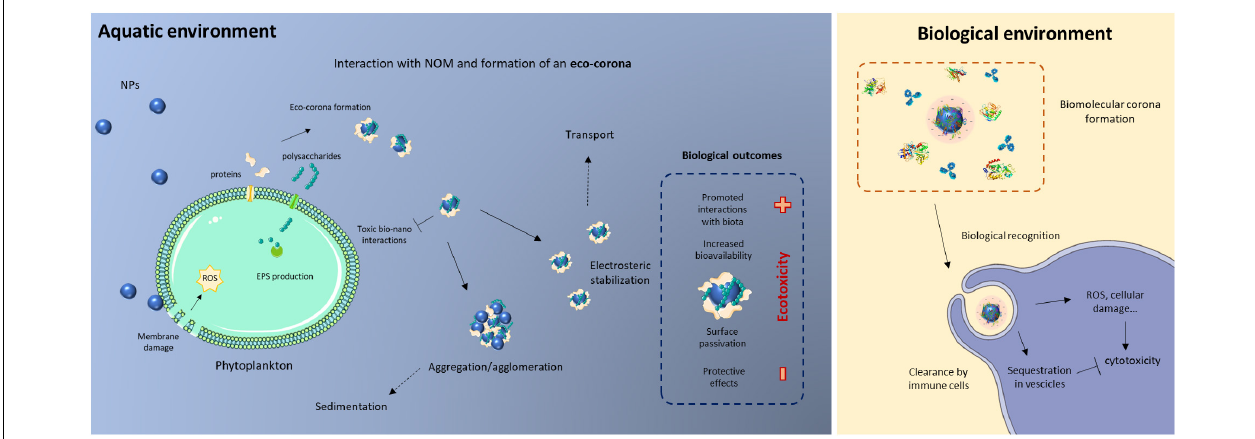
FIGURE 1 | Schematic illustration of the bio–nano interactions taking place in the marine environment. Left: possible interactions between nanoscale particles (NPs) dispersed in seawater and biomolecules making up the marine natural organic matter (NOM) pool, such as microalgal/cyanobacterial extracellular polymeric substances (EPS). Right: the cellular processes following biomolecular corona formation in biological fluids of marine invertebrate